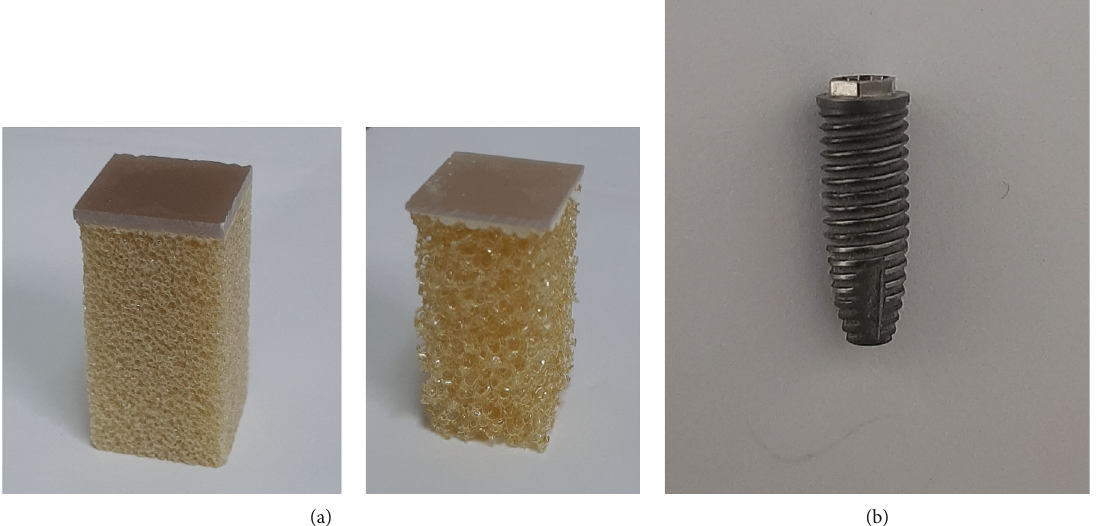
Figure 1: Arti fi cial foam bone and dental implant used in this study: (a) arti fi cial bone consisting of cellular rigid polyurethane foam blocks and an arti fi cial solid shell. Right: good bone, left: poor bone. (b) Dental implant.